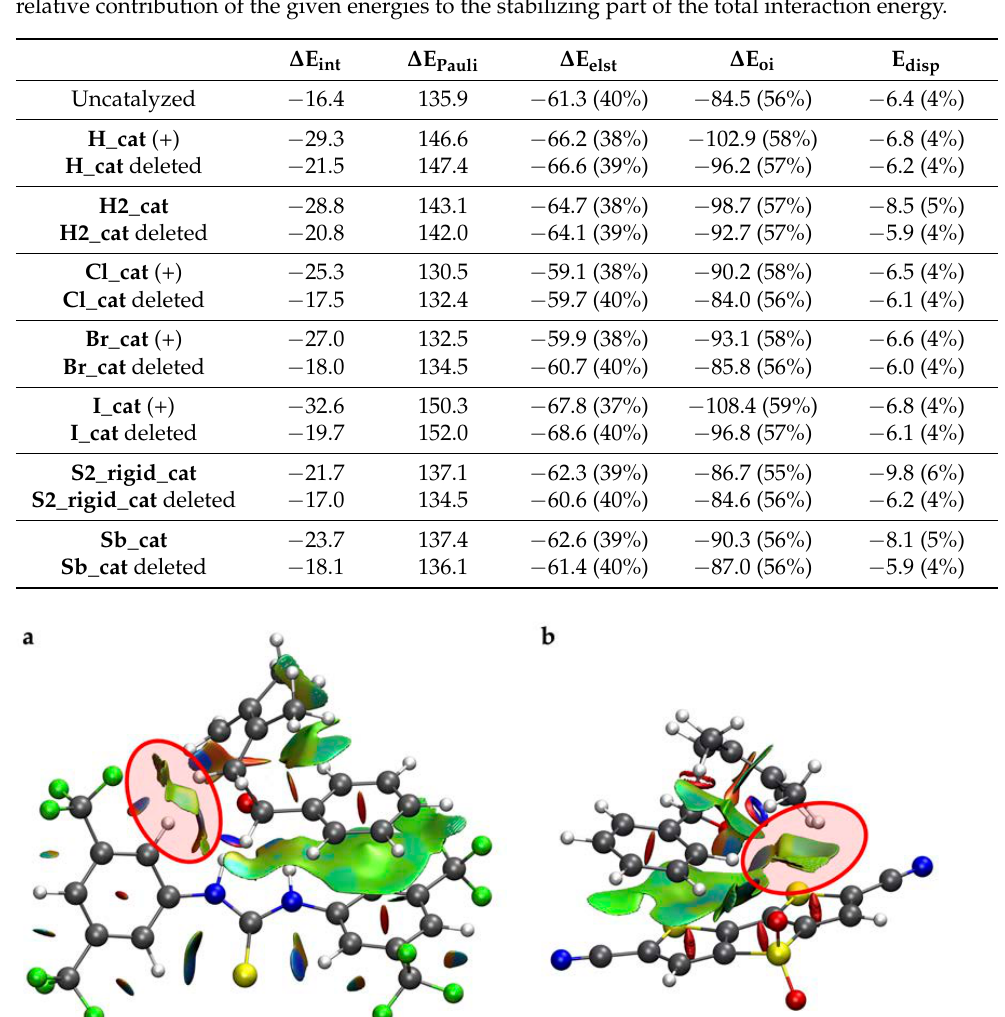
Figure 6. Additional dispersion interactions between the catalyst (( a ) H2_cat; ( b ) S2_rigid_cat), in interaction with the dienophile, and the diene, further stabilizing the transition-state geometry (see red circles). Green indicates π - π and Van der Waals interactions, blue strong non-covalent bonds and red repulsive interactions such as ring strain.